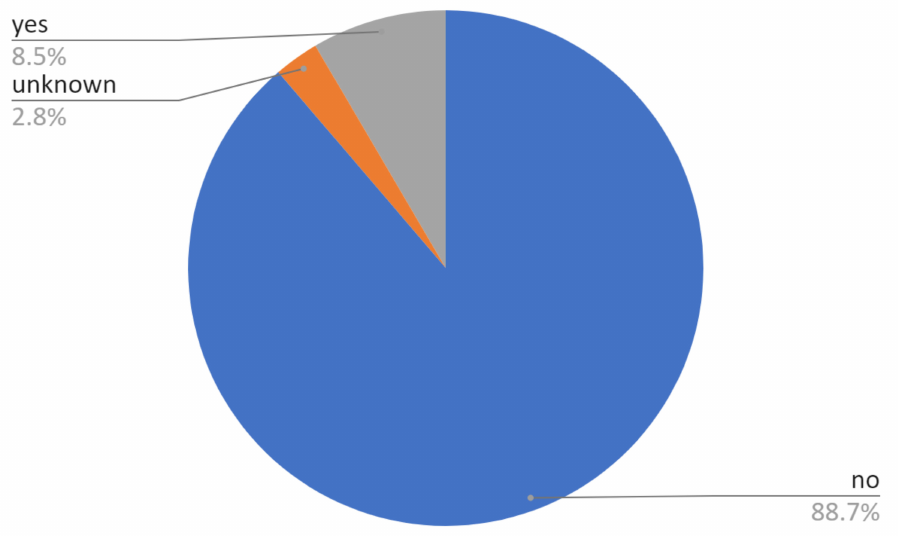
Figure 4. Coastal/non-coastal location of study